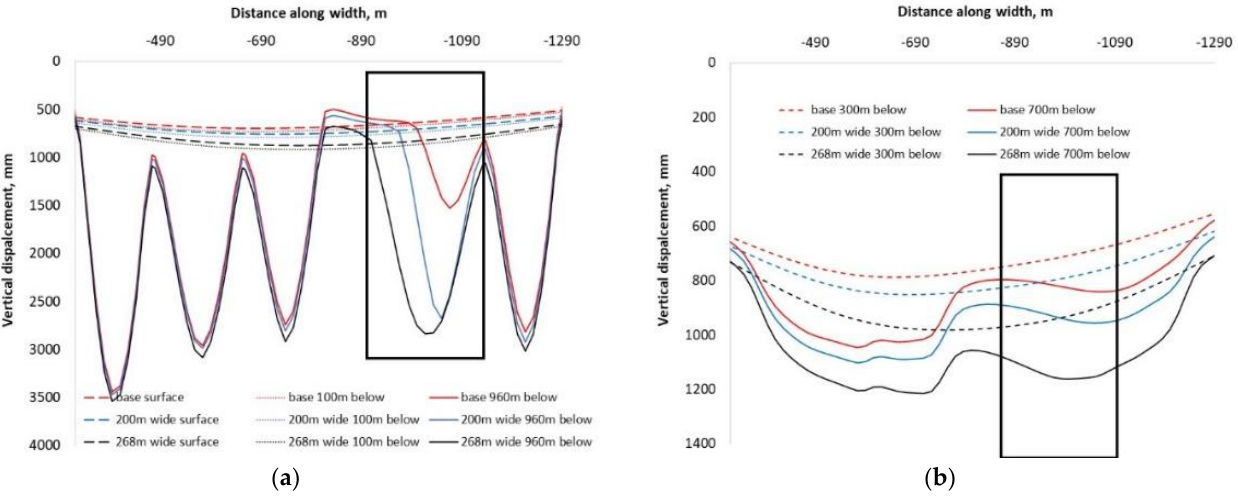
Figure 8. Vertical displacement due to varying excavation widths. ( a ) at surface, 100 m and 960 m below the ground surface; ( b ) 300 and 700 m below the ground surface.